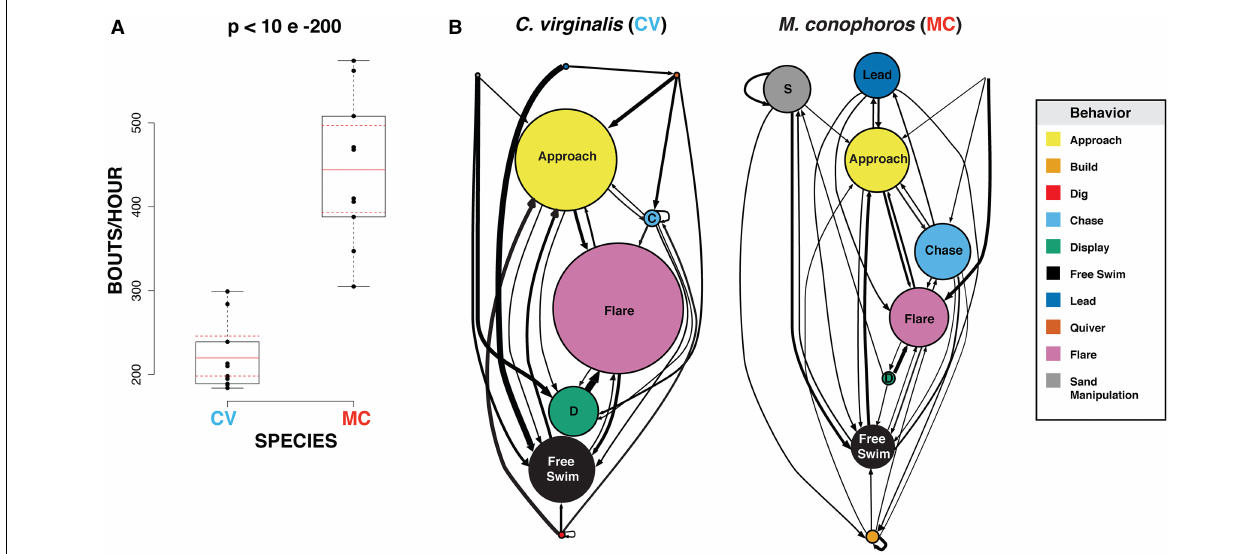
FIGURE 5 | Bower-building and courtship behavior of Mchenga conophoros and Copadichromis virginalis. (A) Mchenga conophoros males perform significantly more building bouts during peak activity compared to Copadichromis virginalis . (B) Node diameter represents average number of occurrences for each